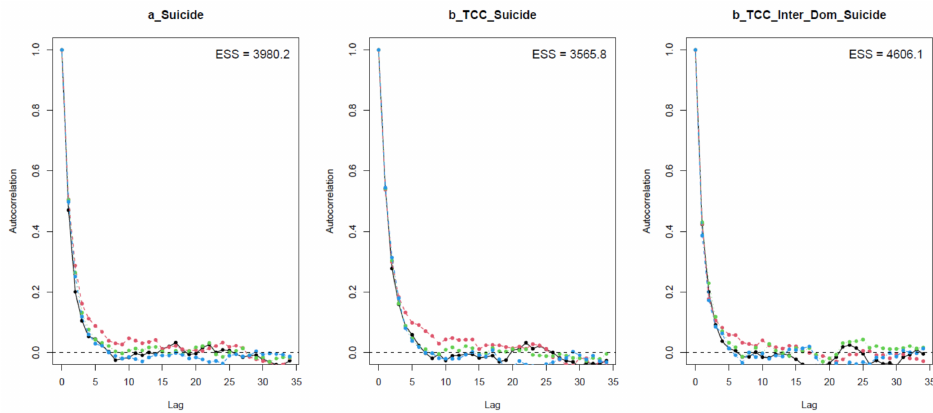
Figure A2. Autocorrelation plots for Model 1 (cid:48) s posterior